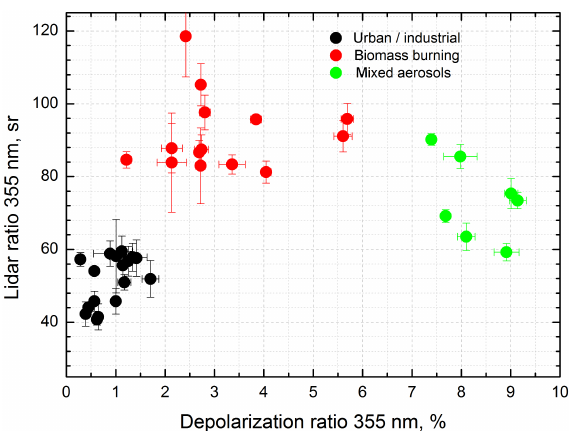
Figure 6. Lidar ratio at 355nm vs. the depolarization ratio at 355nm for the three aerosol types investigated in our